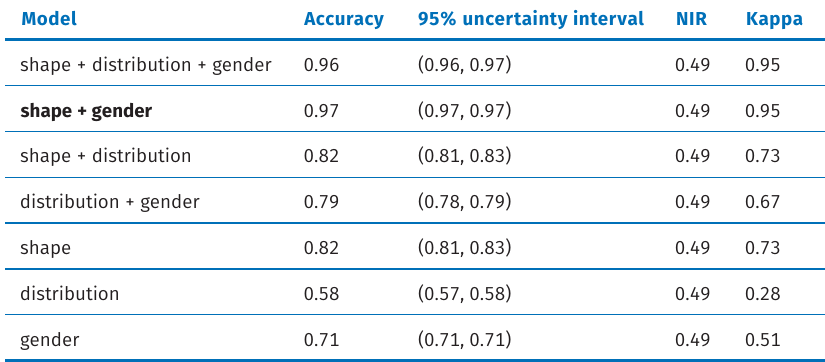
for inanimate instrumental plural